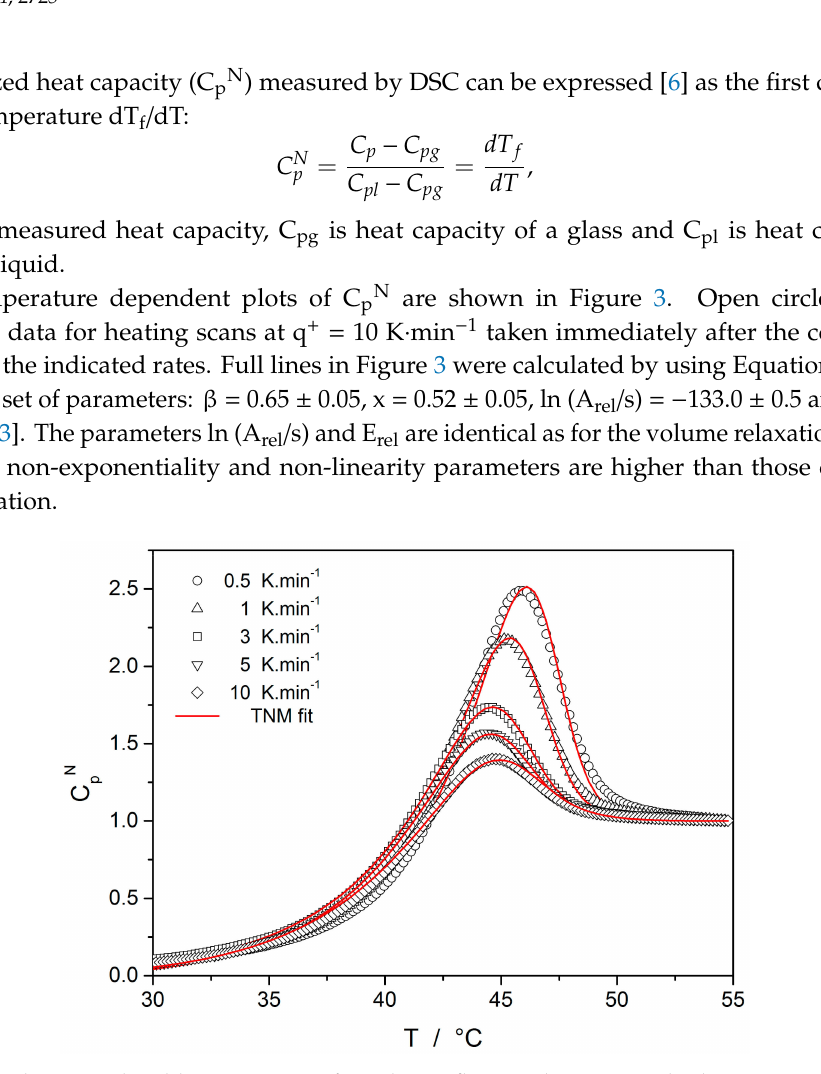
Figure 3. The normalized heat capacity of Se glass reflecting the structural relaxation in the glass transition range. Points correspond to selected experimental data-curves obtained by di ff erential scanning calorimetry (DSC). Full lines were calculated for the TNM model (parameters in